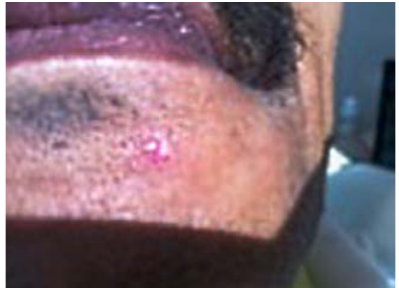
Figure 1. 24 h Pre-op extra-oral mild